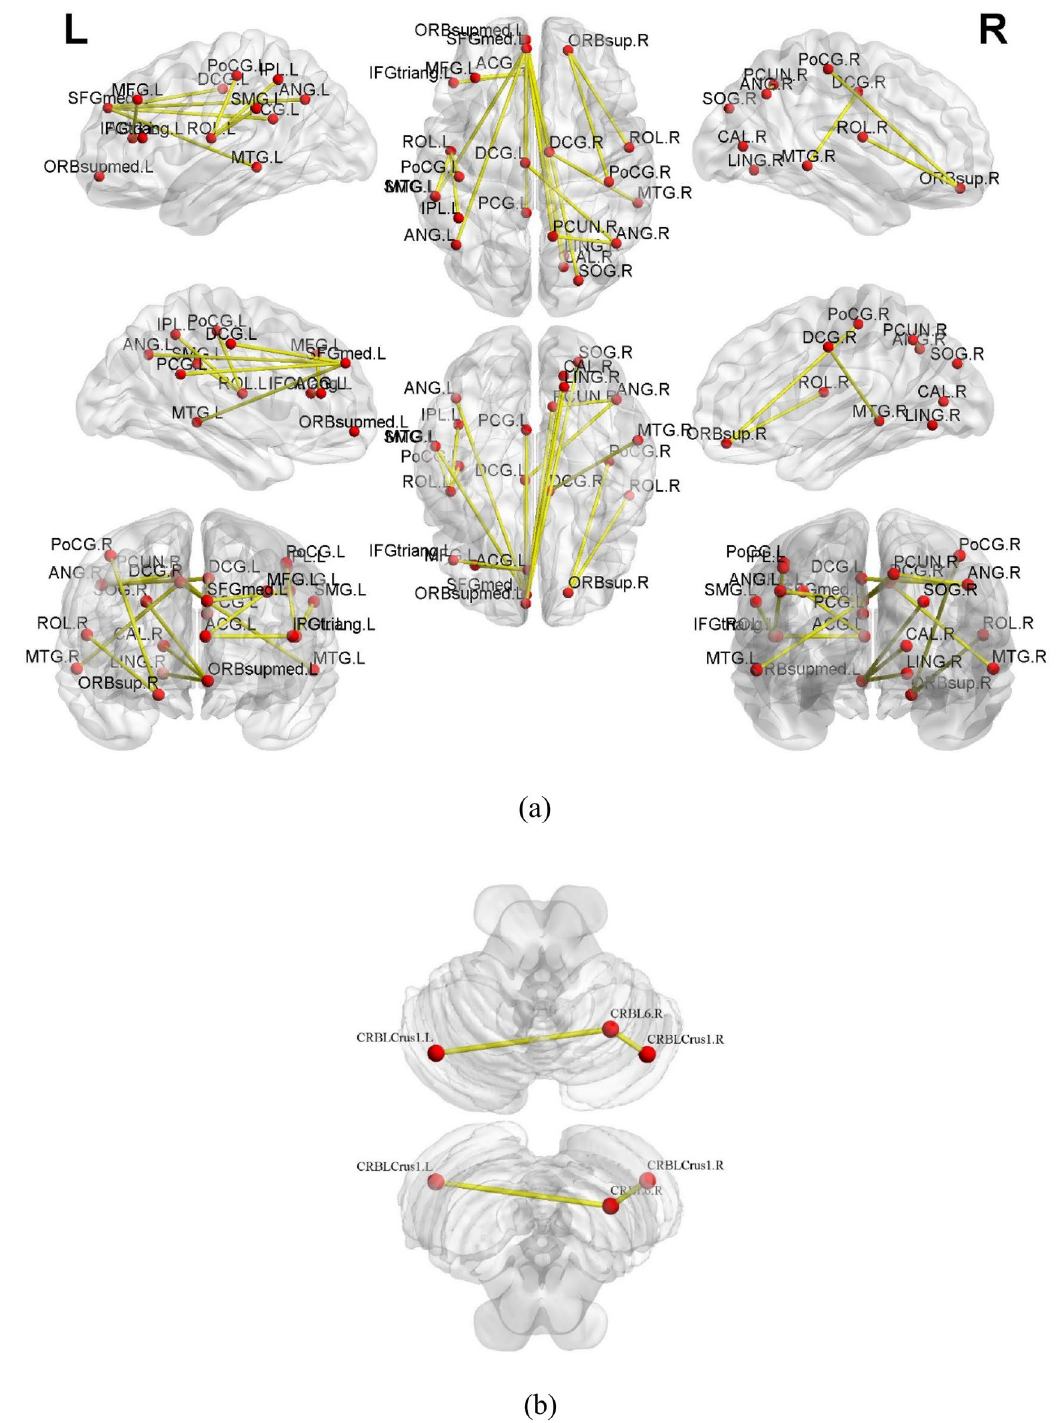
Figure 3. Visualisation of Table 3 created from brain region point of view: ( a ) decreased functional connectivities in CI patients and ( b ) increased functional connectivities in CI